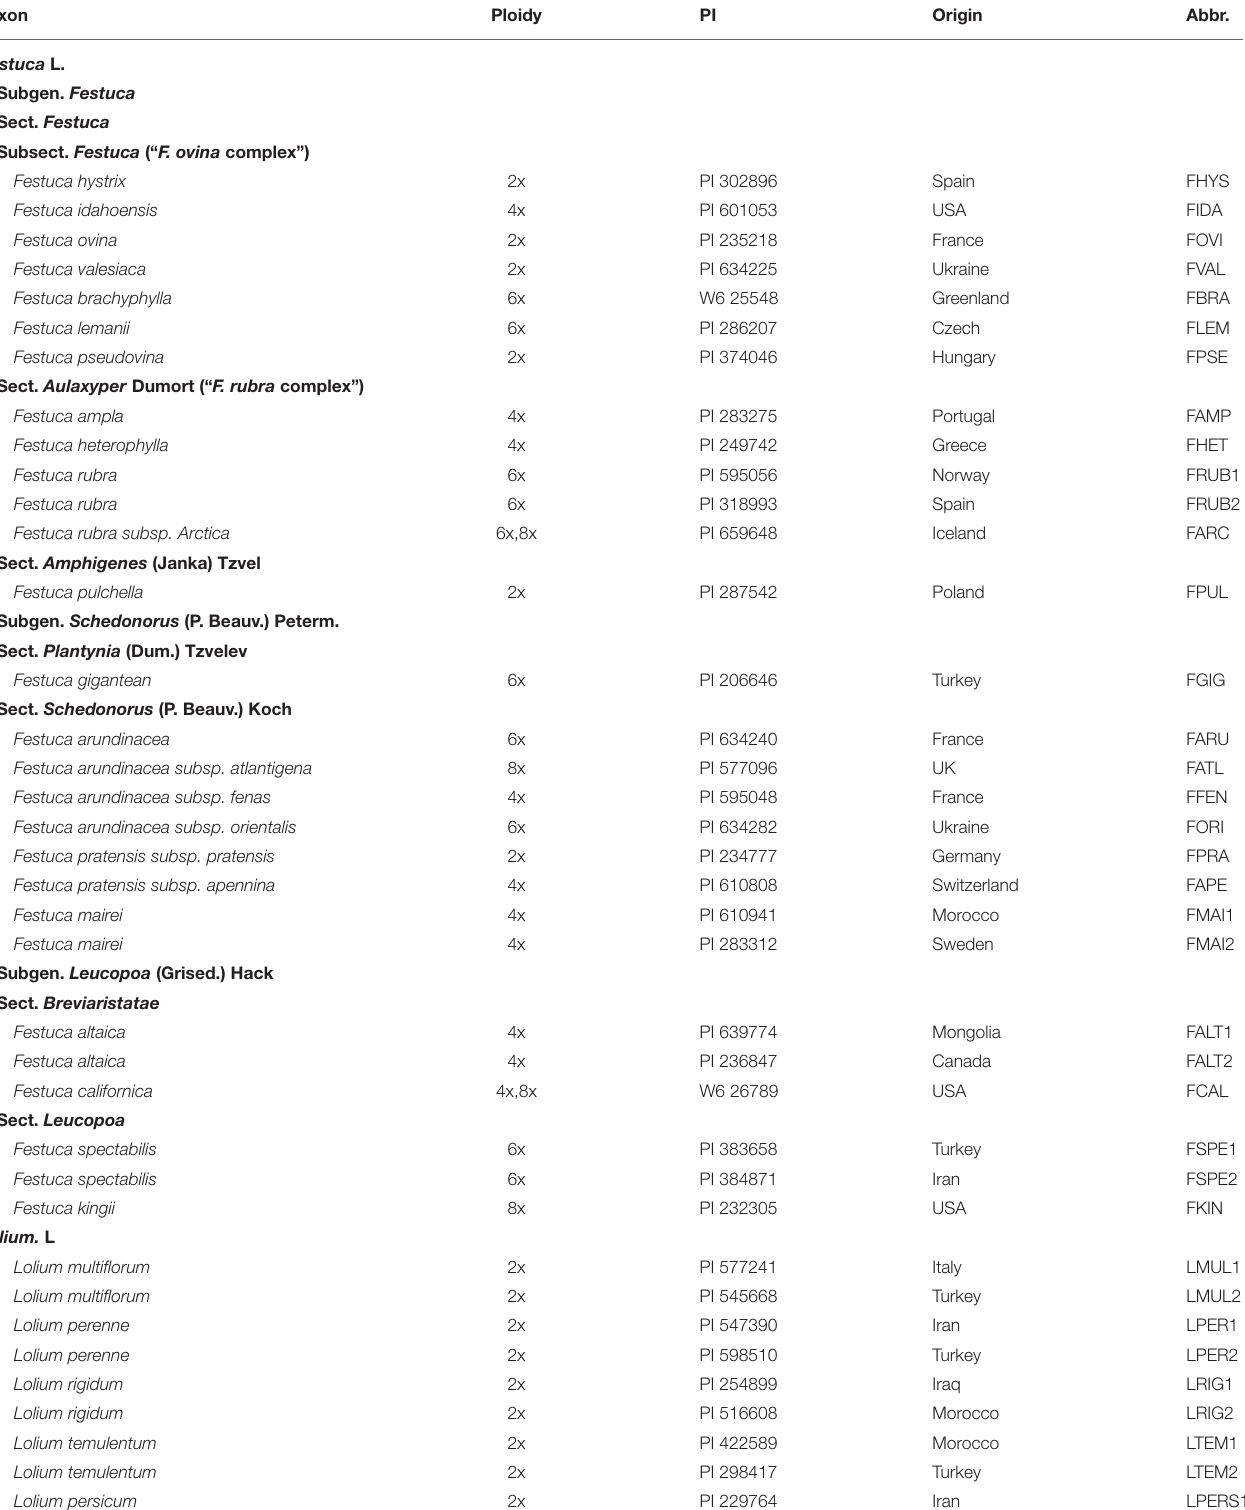
TABLE 1 | List of Lolium / Festuca examplers and the outgroup used in this study. Taxon Ploidy PI Origin